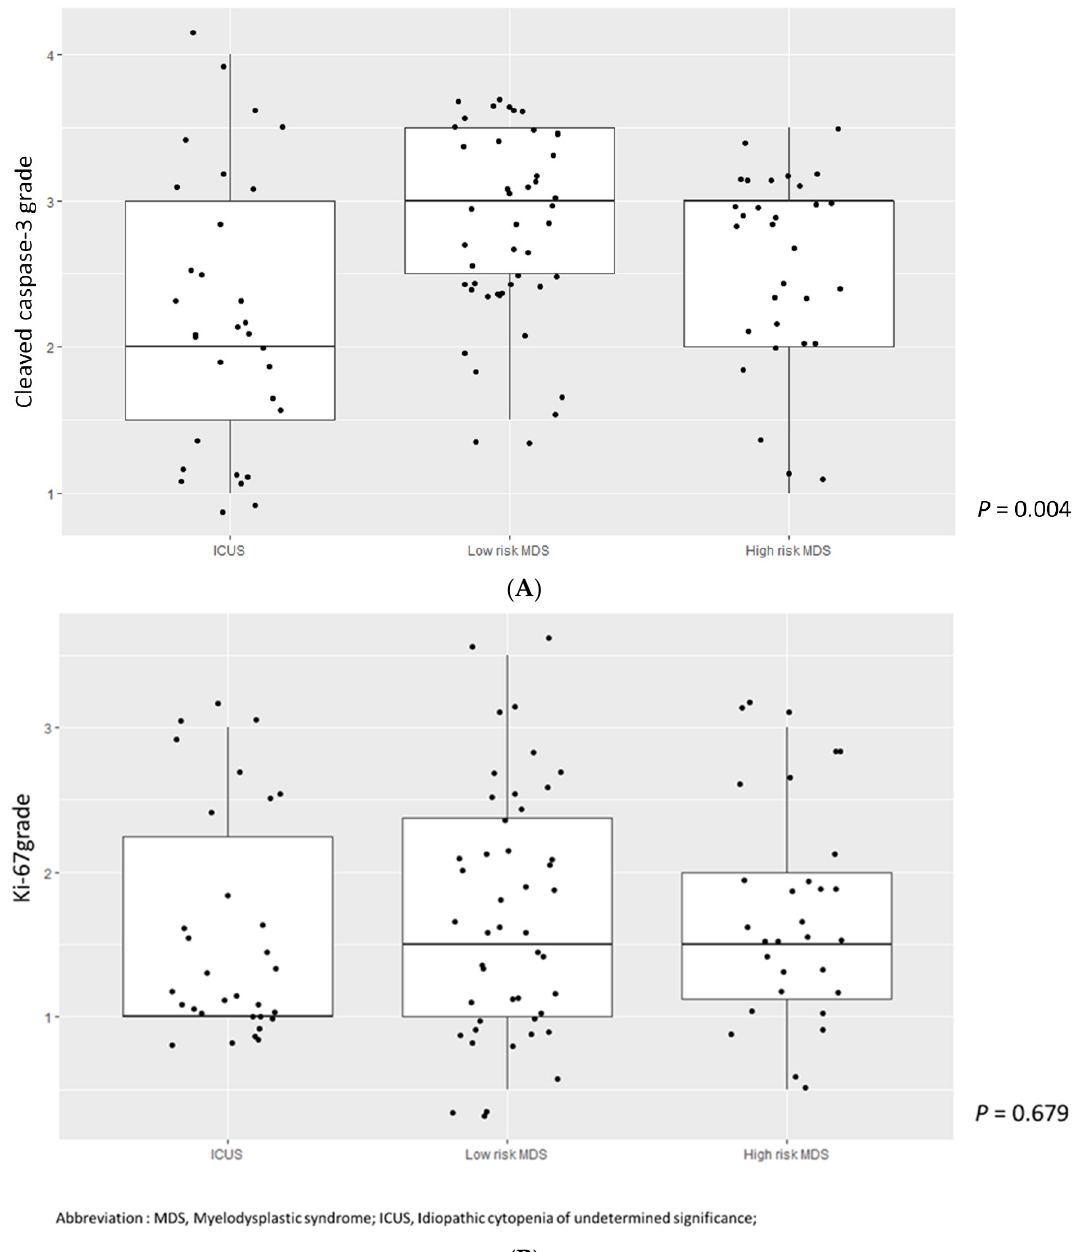
Figure 3. ( A ) Cleaved caspase-3 grade in patients with ICUS, low risk MDS and high risk MDS. Abbreviation: MDS, Myelodysplastic syndrome; ICUS, Idiopathic cytopenia of undetermined significance. ( B ). Ki-67 grade in patients with ICUS, low risk MDS and high risk MDS. Abbreviation: MDS, Myelodysplastic syndrome; ICUS, Idiopathic cytopenia of undetermined significance.